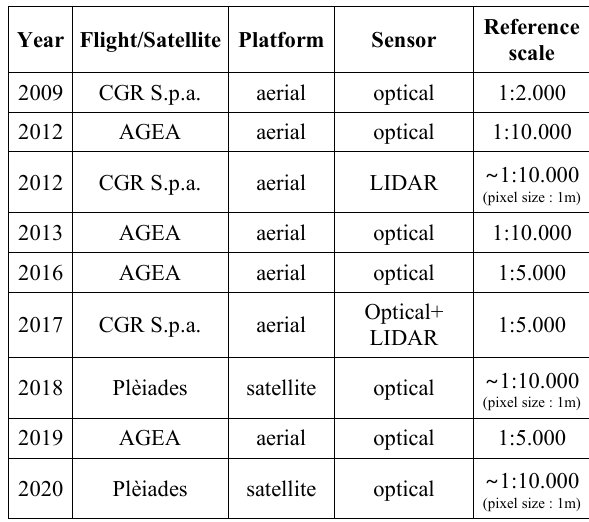
Table 1. High resolution aerial images/LIDAR surveys available by Geoscopio WMS services. Satellite images availability was granted by the European Space Agency (ESA) via the Airbus GeoStore